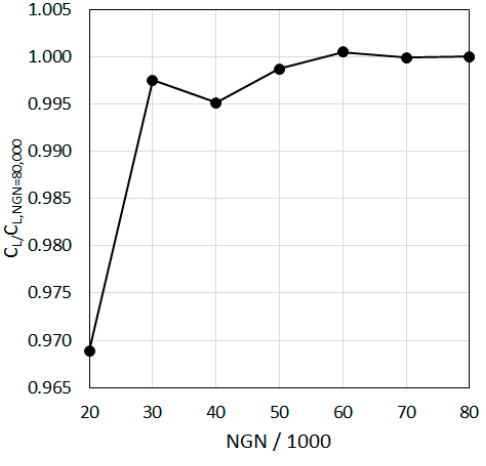
Figure 5. Variation of predicted lift coefficient with grid resolution.